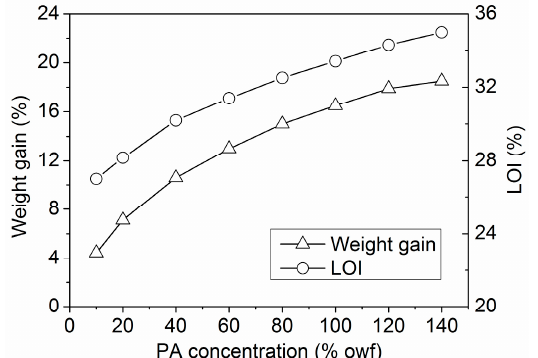
Figure 5. Weight gain and LOI of the wool fabrics treated with PA.